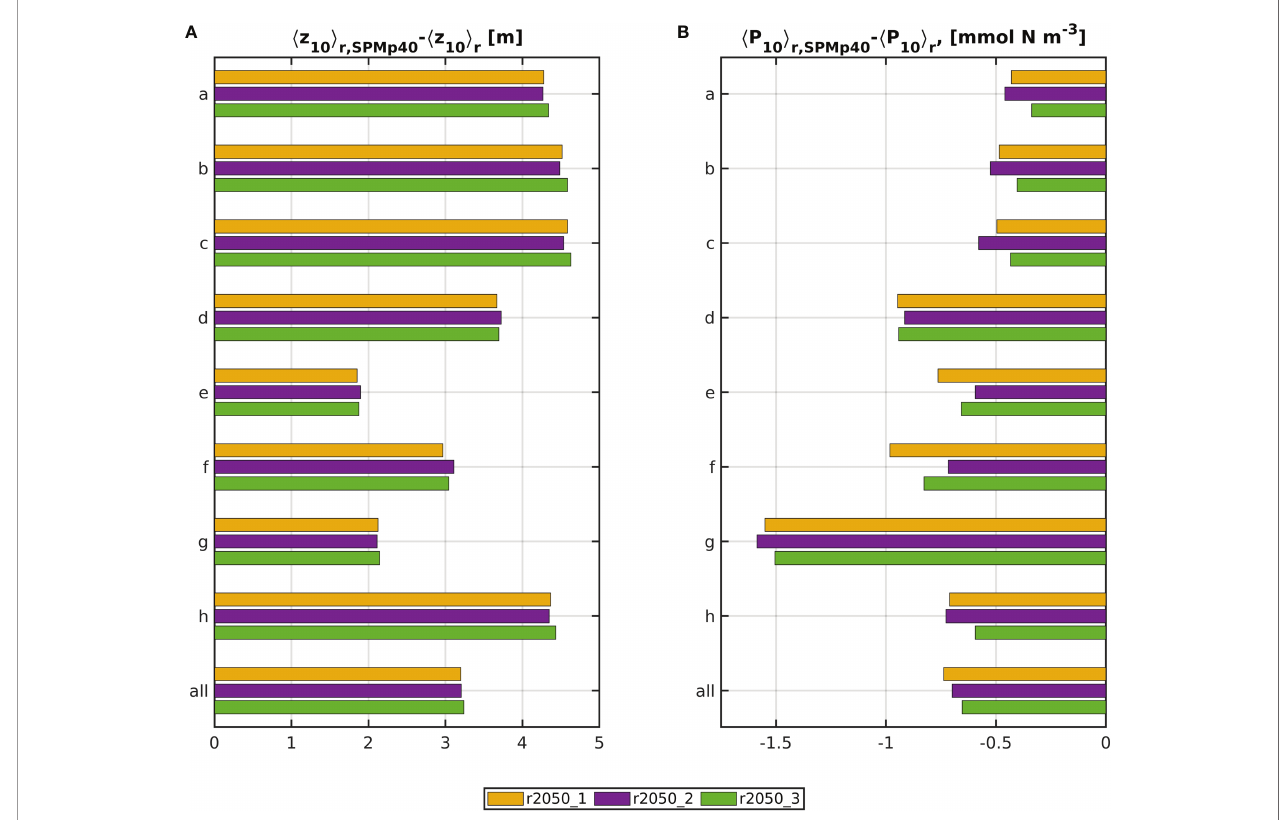
FIGURE 8 | Differences in 5-year means of <Z 10 > r and <P 10 > r between the SPMp40 runs and the base runs. Yellow is r2050_1, purple is r2050_2 and green is